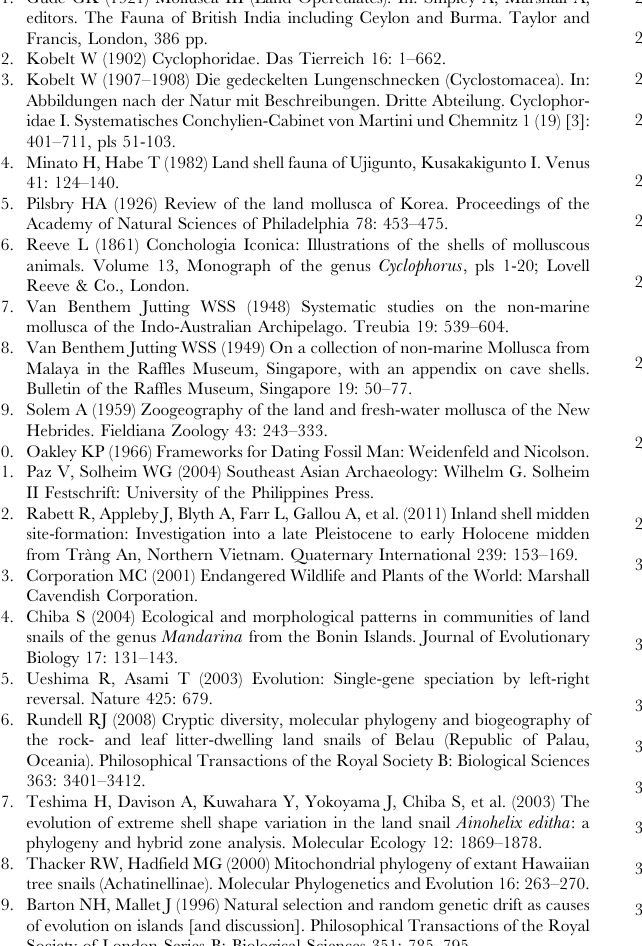
Figure S4 Maximum-likelihood phylogenetic tree of the Cyclo- phorus fulguratus species complex and related species constructed using the COI gene (660 bp). Table S1 Tree topologies of Clade B for each dataset. (DOC) Material S1 The concatenated